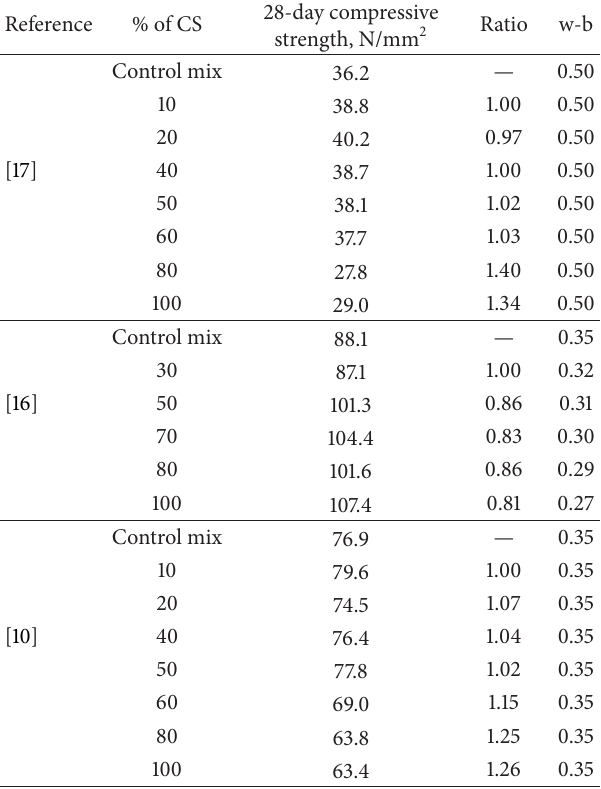
Table 4: Experimental results from the references (Poon 2009, [2, 13]).